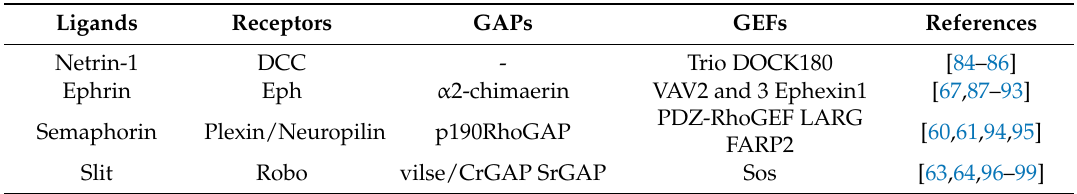
Table 1. GTPase-activating proteins (GAPs) and guanine nucleotide exchange factors (GEFs) in guidance cue/receptor signaling